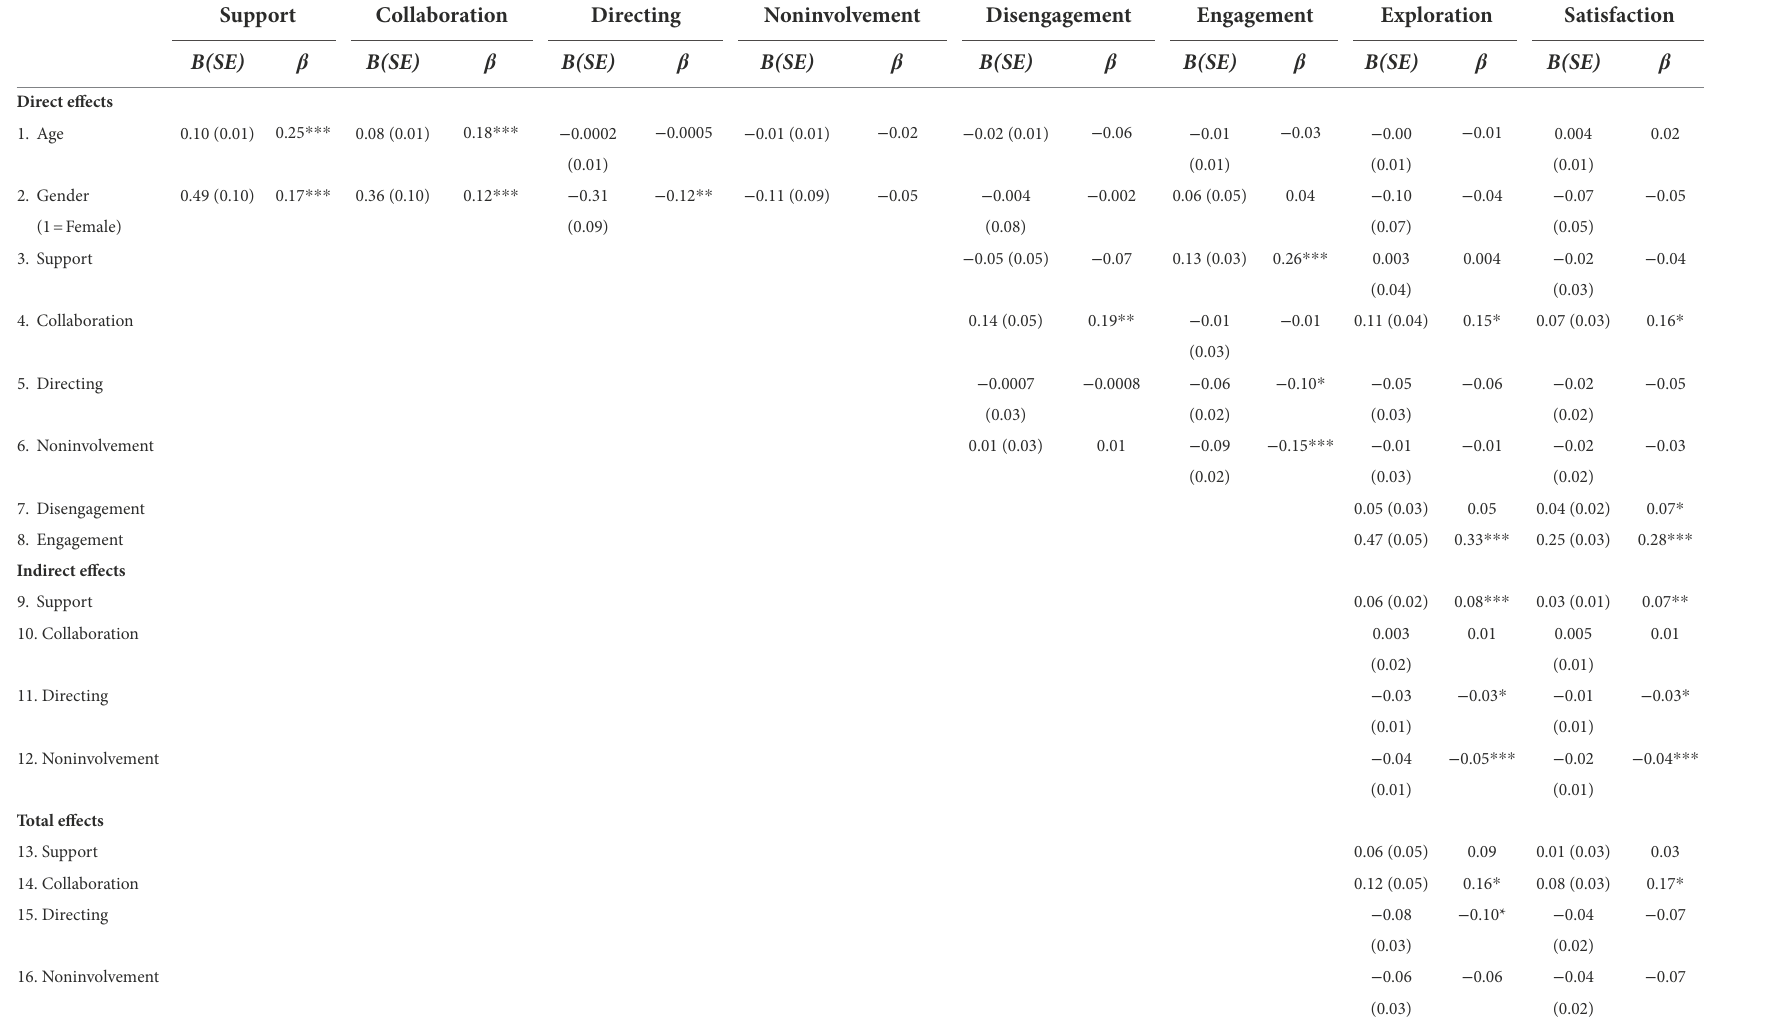
TABLE 6 Direct, indirect, and total effects of shared and nonshared agency from romantic partners on occupational